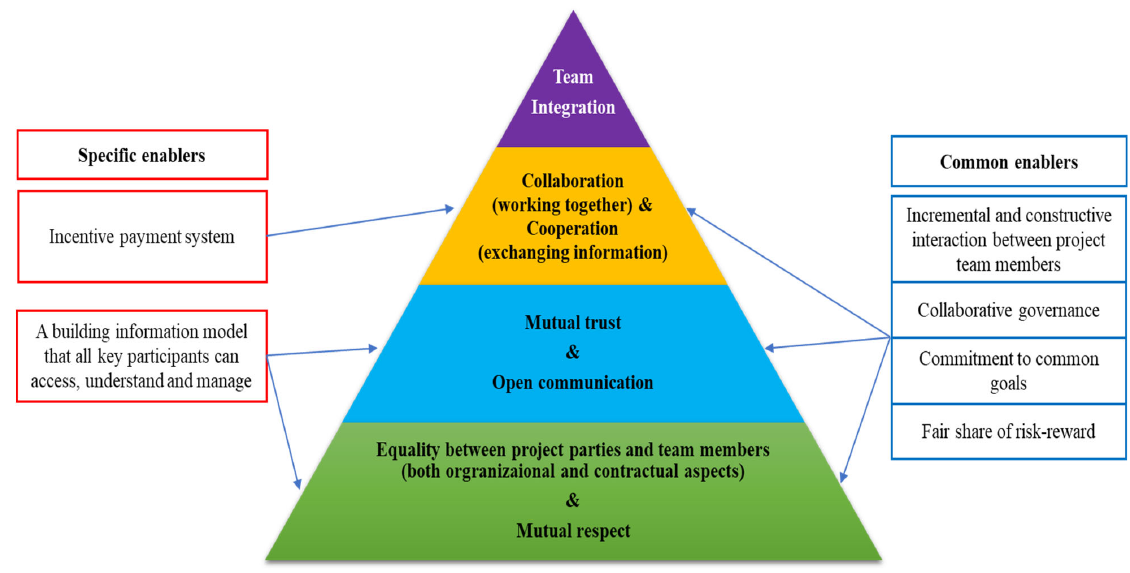
Figure 4. Pyramid model for collaborative project